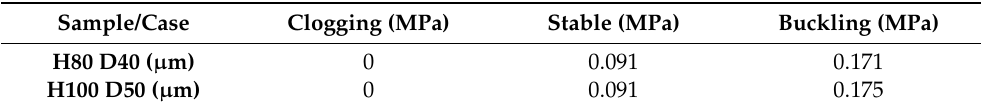
Figure 3. ( a , b ) SEM and optical microscopy (OM) images of constructed polymeric stencil membranes with aspect ratio of 2 and imprint pressure variation. Structural geometry with a diameter of 40 µ m and a height of 80 µ m ( a ), and a diameter of 50 µ m and a height of 100 µ m ( b ). Table 1. Applied imprint pressure during fabrication of polymeric stencil membranes with aspect ratio of